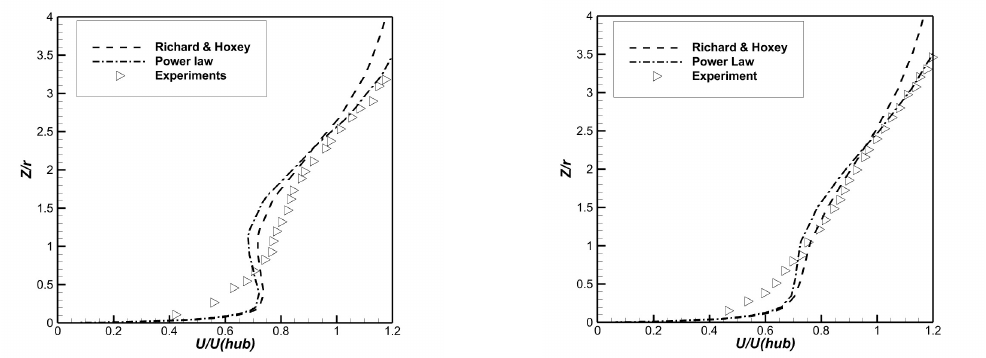
Figure 6. Power law and logarithmic velocity profile in the far wake at 10 D ( left ) 15 D ( right ).